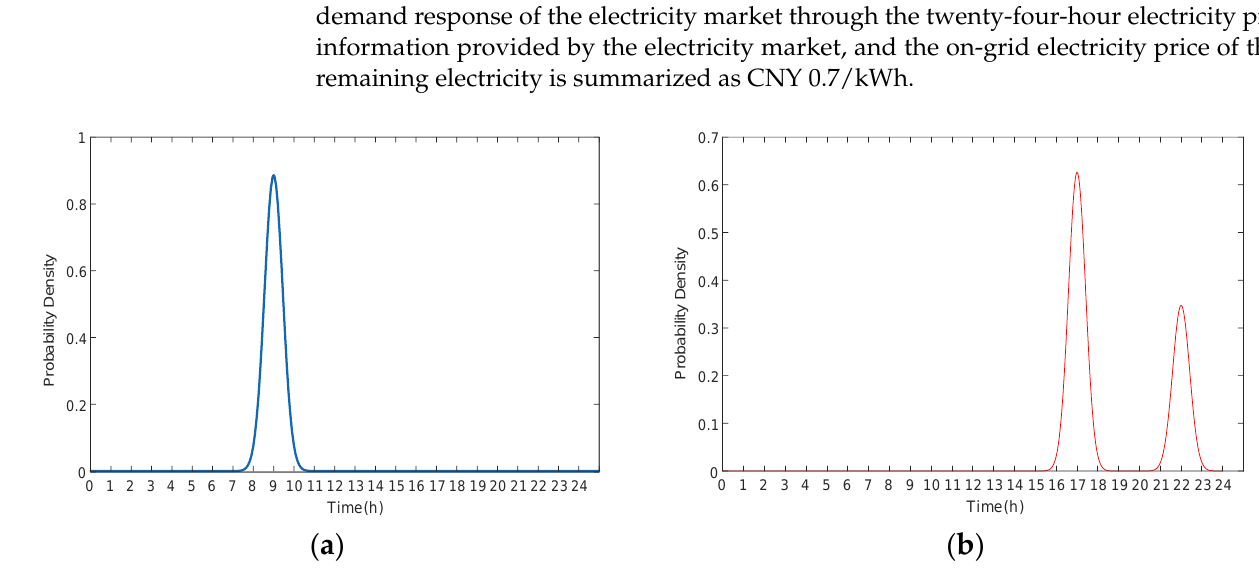
( b ) Figure 4. Natural gas and electricity purchased/sold results: ( a ) before optimization; ( b ) after opti- mization.